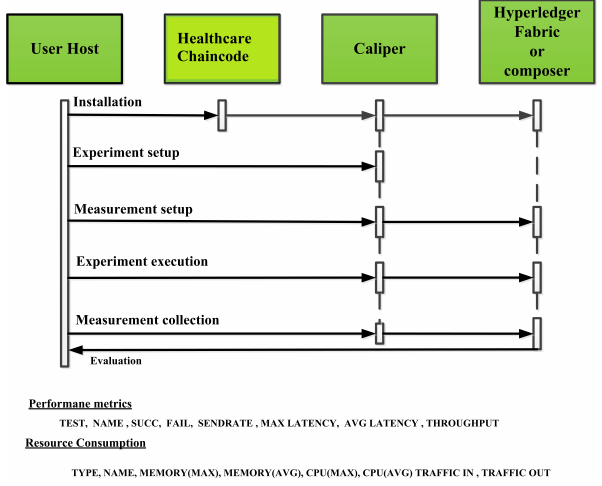
Figure 16. Caliper benchmarking